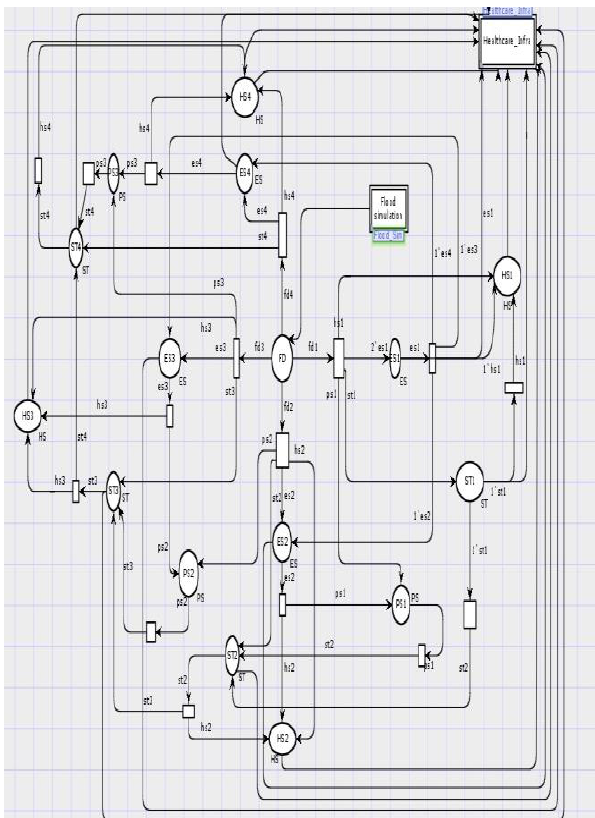
Figure 5 . Interdependent Healthcare Critical Infrastructure Network CPN (Nivedita and Durbha, 2014)